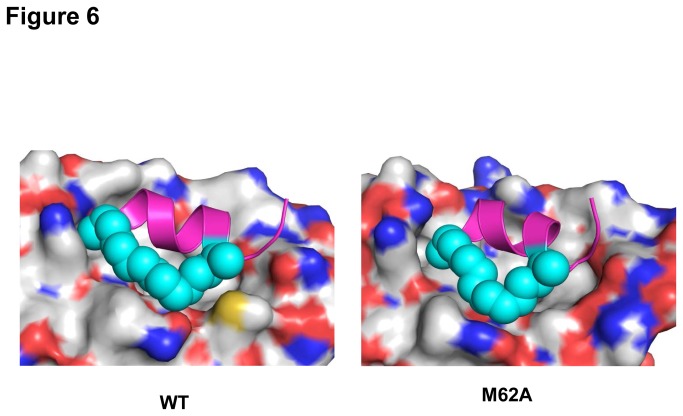
The M62A mutation in HDM2 does not perturb binding of the stapled peptide PM2.Left: Simulations (see Materials and Methods) indicate packing interactions between M62 (yellow) and hydrophobic staple (cyan) of PM2. Right: Mutation to alanine results in loss of these interactions, but numerous other interactions persist between PM2 and hydrophobic cleft of HDM2. The peptidic component of PM2 is depicted in magenta.